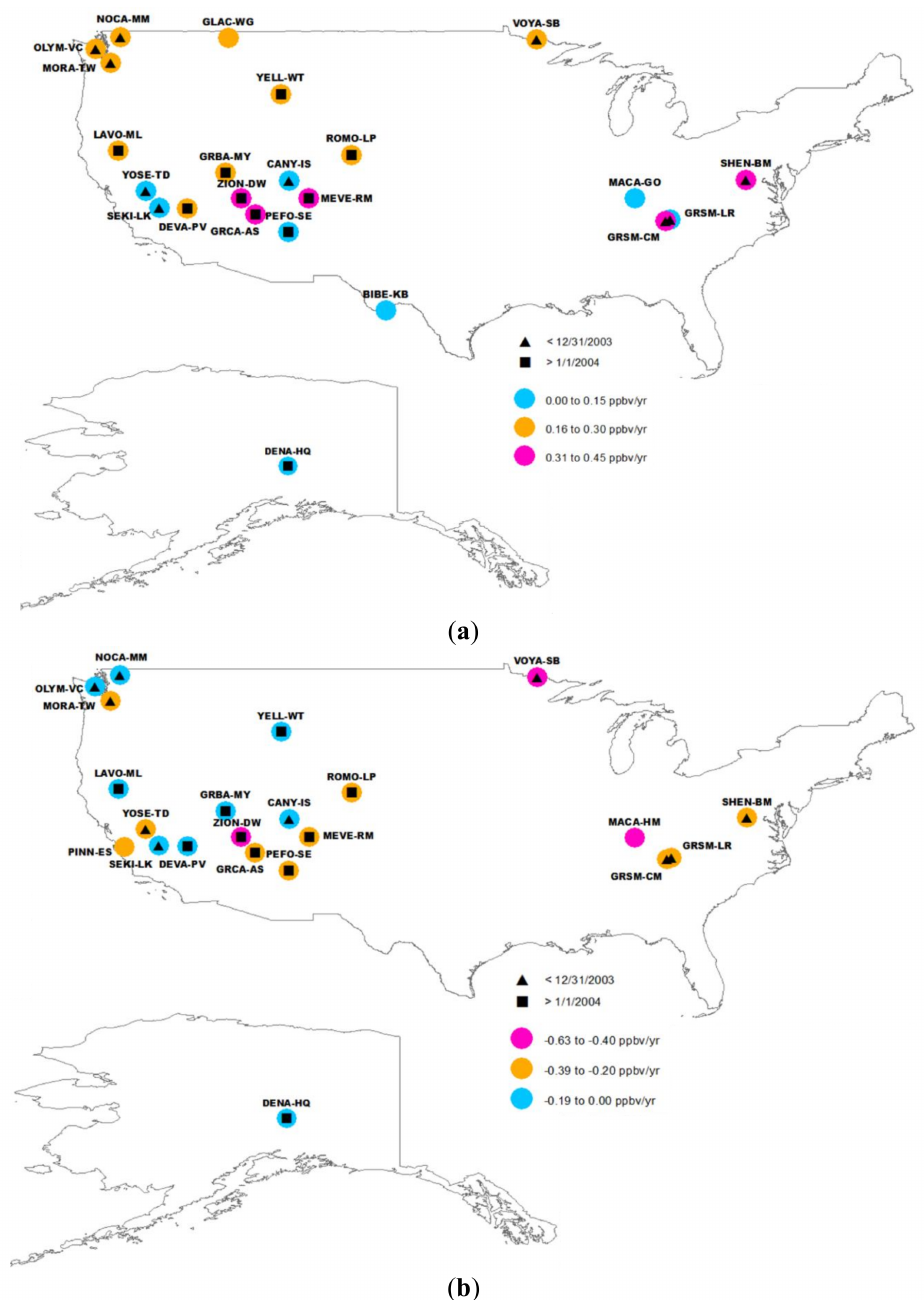
Figure 3. Increasing ( a ) and decreasing ( b ) trends in ppbv yr − 1 for all of the sites in the study. The date of trend changes from positive to negative are symbolized for each site. Sites that changed prior to 31 December 2003 are symbolized by triangles and sites that changed after 1 January 2004 are symbolized by